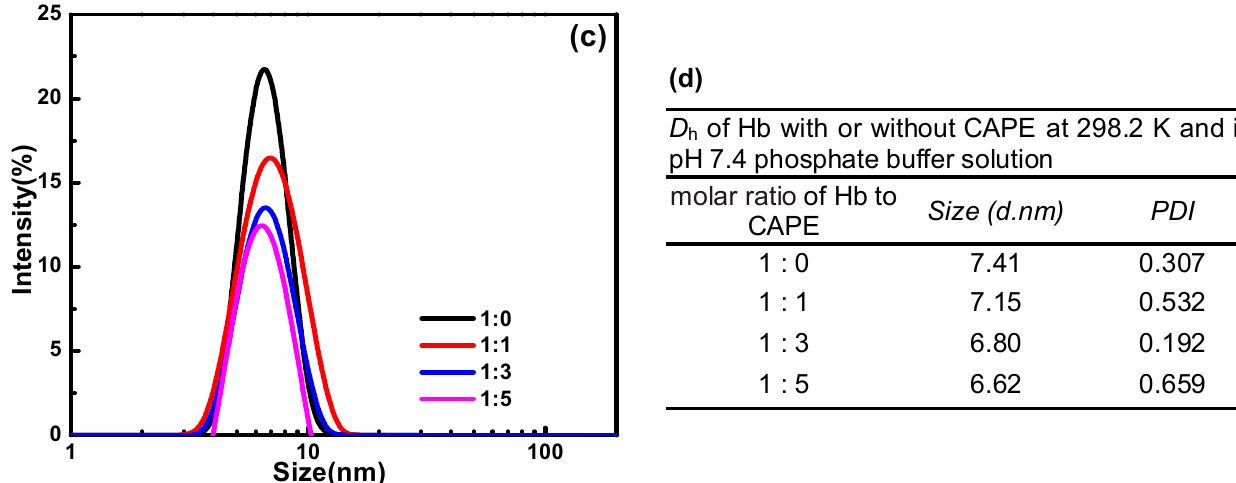
Figure 3. ( a ) UV − Vis absorption spectra; ( b ) CD spectra; ( c ) DLS diagram; and ( d ) D h data of Hb with or without CAPE for the CAPE–Hb system at 298.2 K and in pH 7.4 phosphate bu ff er solution.